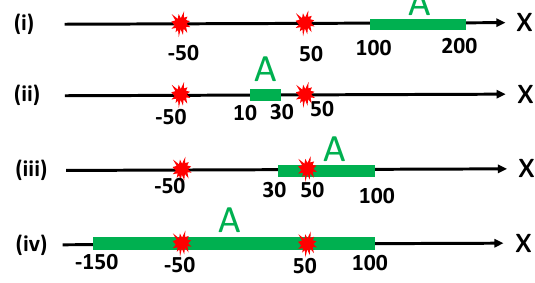
Figure 15 . Top: the behaviors of connected holographic entanglement entropy S con at t = 0 and A b = 50 for the double local quench (blue) and the sum of two single local quenches (orange) at a = 1 (left), a = 10 (middle) and a = 100 (right). We chose the subsystem A to be A = [ x 1 ; x + 1] (cid:0) and plotted (cid:1) S con as a function x . In the left graph at a = 1, the blue and orange graphs almost A coincide. Bottom: the di(cid:11)erence (cid:1) S D (cid:1) S S ( x = b ) (cid:1) S S ( x = (cid:0) b ) for connected geodesics. A (cid:0) A (cid:0) A